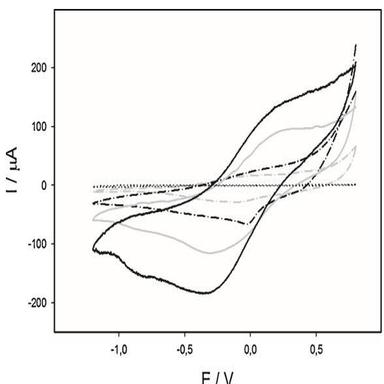
Cyclic voltammograms of polypyrrole and its composites synthesized on GC electrodes. Solid black line – Ppy–Au, solid grey line – Ppy– S2O8, dasheddotted black line – PPy–Ag 1, dashed-dotted grey line – PPy–Ag 2, dotted line – background on non-modified GC electrode. Conditions: 0.5 M LiClO4, 50 mV/s, degassed.